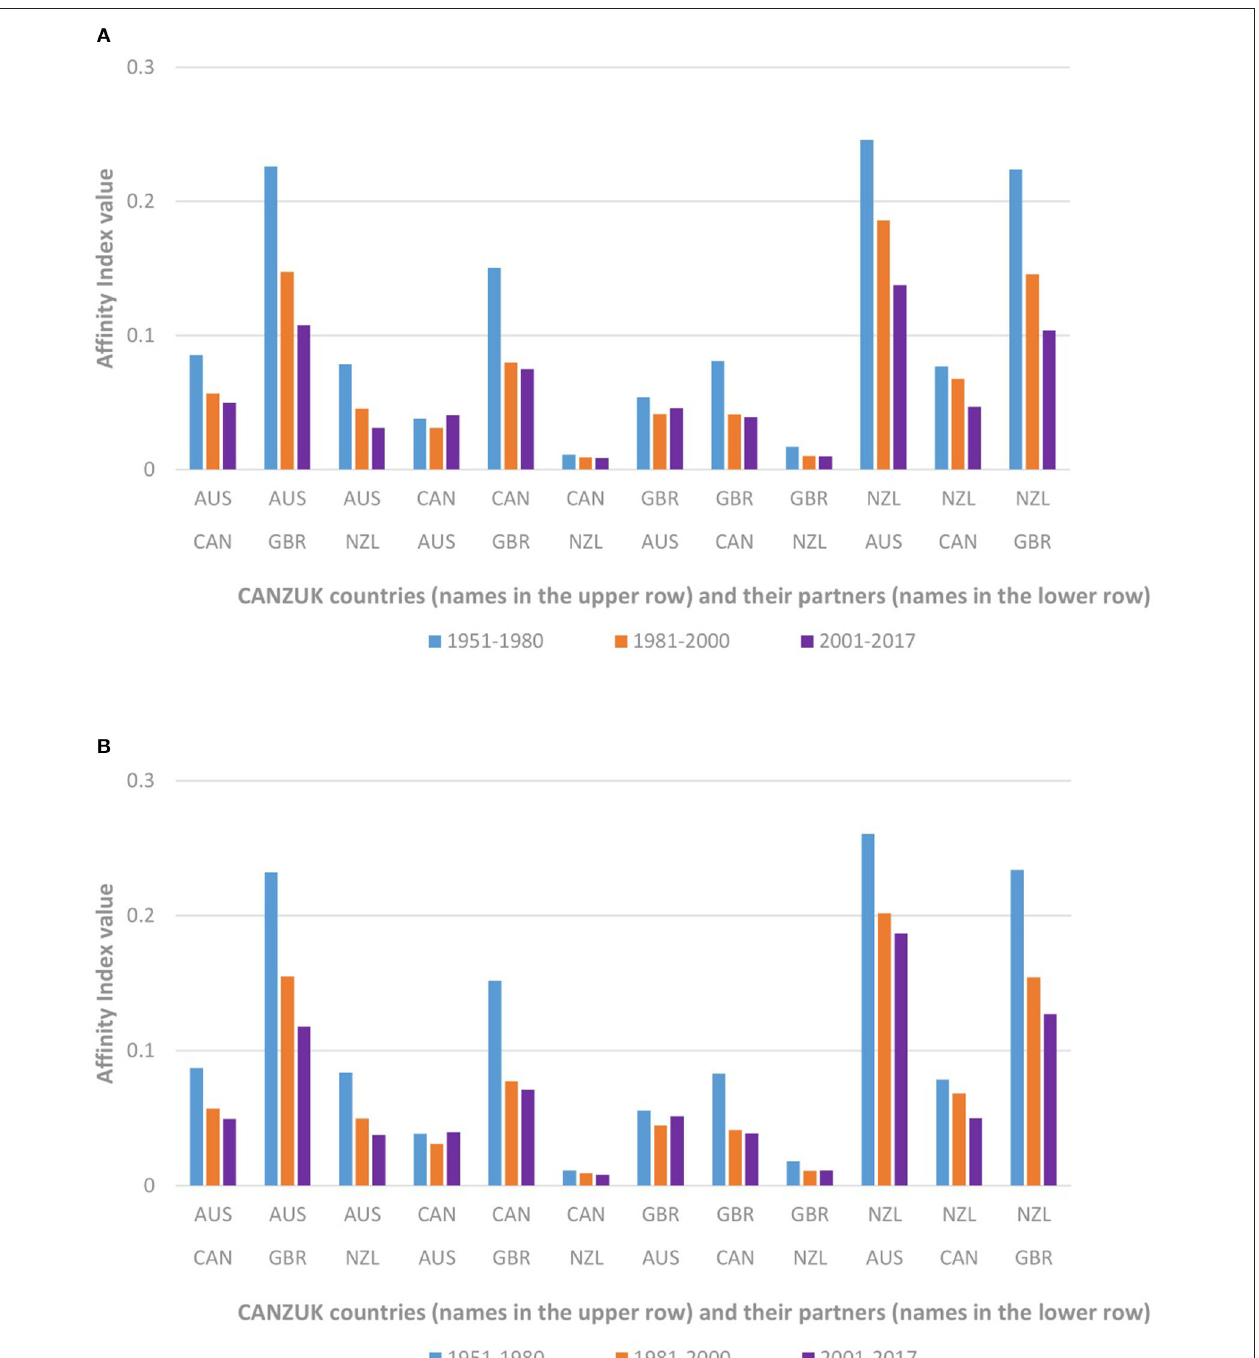
FIGURE 2 | The affinity index values of CANZUK countries, calculated by (A) whole counting, and (B) fractional counting. The affinity index values of research collaborations between CANZUK countries and their counterparts were decreasing over time.